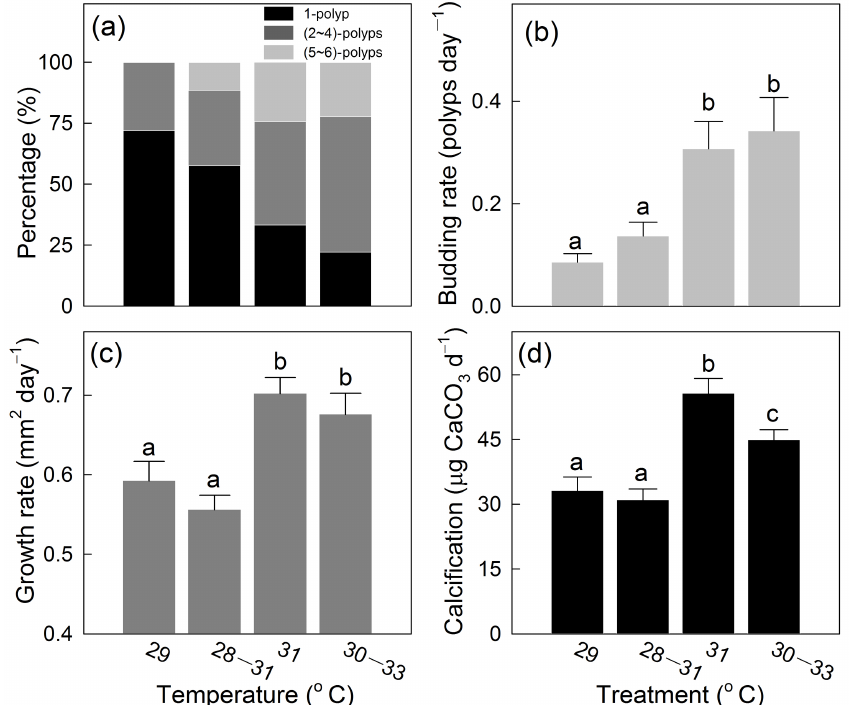
Figure 4. (a) Budding state, (b) polyp formation rate, (c) lateral growth and (d) calcification of P. damicornis recruits under constant and fluctuating conditions of two temperatures (29 and 31 ◦ C). Error bars represent 1SEM ( n = 25–33). Different letters denote significant differences between treatments.